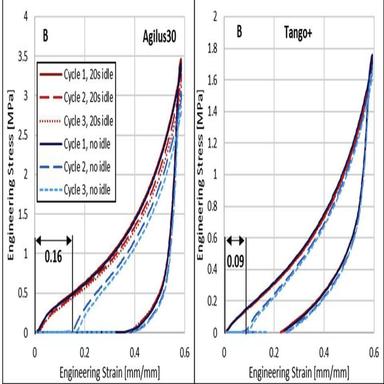
Cyclic loading of A30 and T+ X- samples at strain rates 0.05 /s (blue) and 0.5 /s (red).